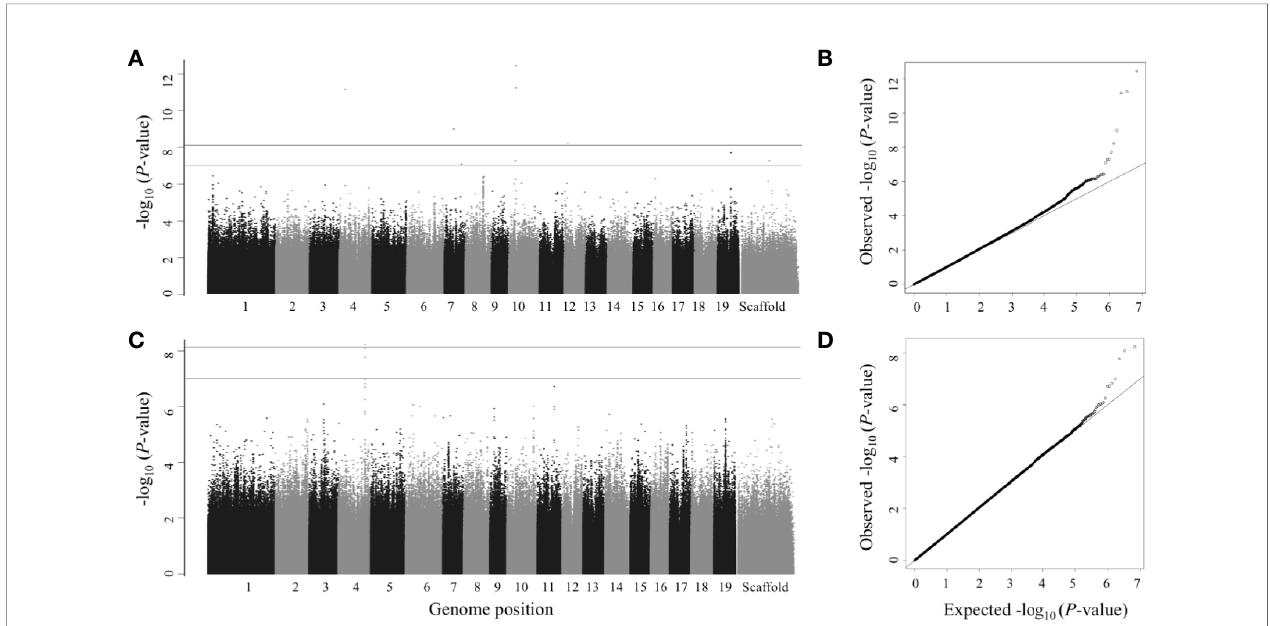
FIGURE 5 | Multitrait GWAS — Manhattan (left) and QQ plots (right). Numbers 1 to 19 represent chromosomes; scaffolds are the reads that did not align to any of the 19 chromosomes. (A , B) Leaf area, leaf dry weight, leaf length and leaf width; (C , D) Vessel area and vessel count (late wood). SNPs above gray line have P <1×10 -7 , which is roughly equivalent to FDR ≤ 0.1 and SNPs above black line (the top line) have P <7.417×10 -9 (the Bonferroni correction threshold), which is roughly equivalent to FDR ≤ 0.05 in this study.